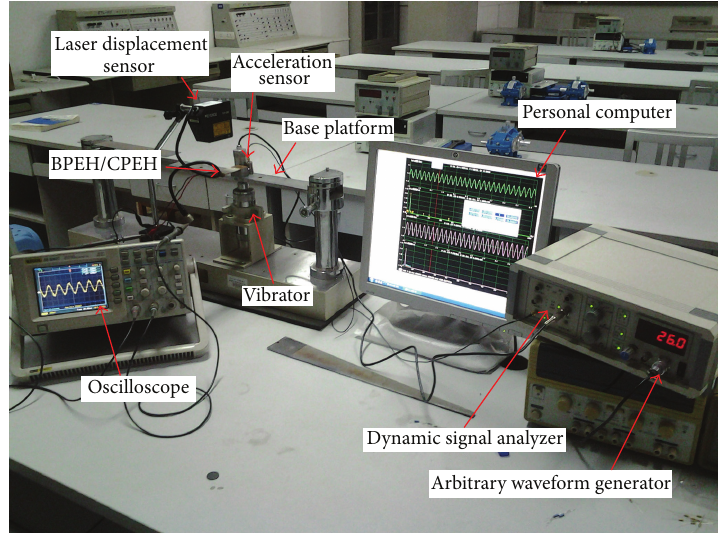
Figure 12: Prototypes of BPEH and CPEH.